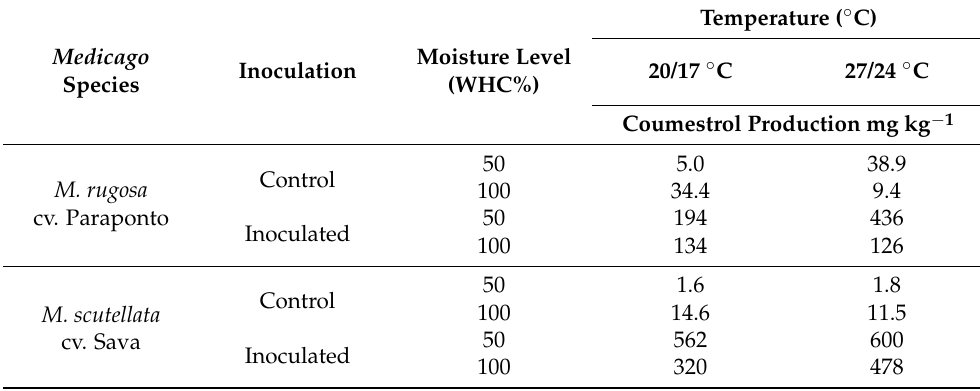
Table 3. Interaction of species with inoculation and with moisture level at 20/17 ◦ C and 27/24 ◦ C in relation to coumestrol production (mg kg − 1